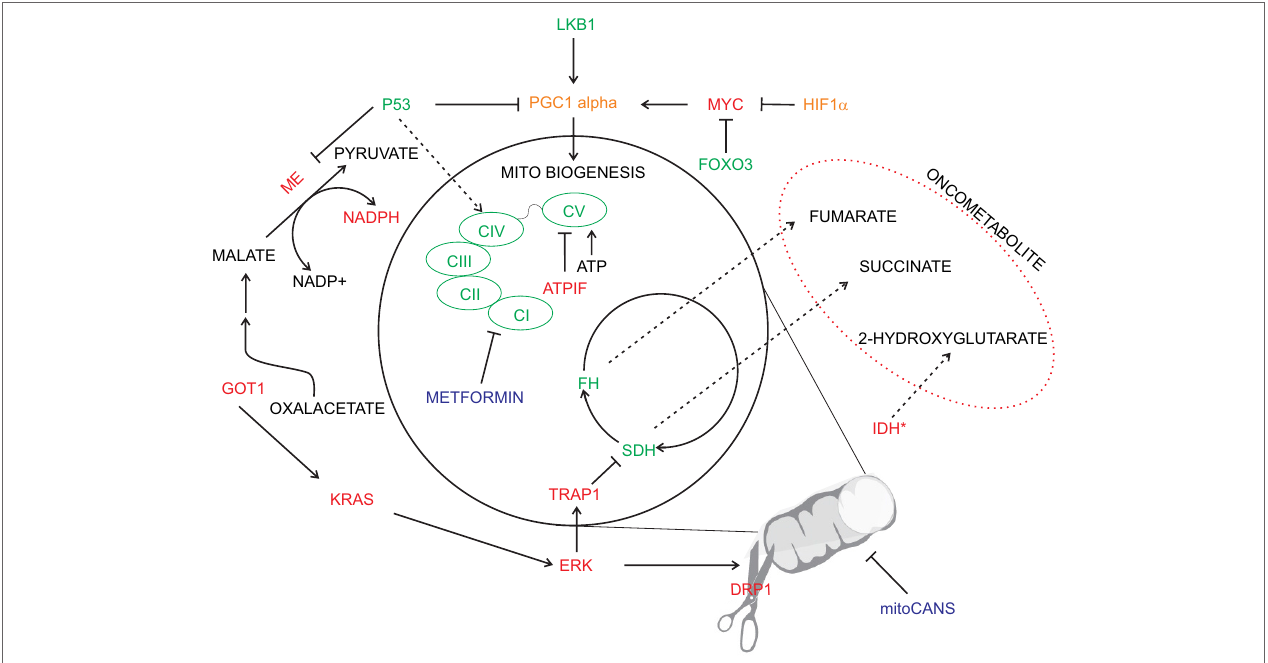
FiGURe 2 | Oncogenic deregulation in mitochondrial metabolism. Physiological mitochondrial metabolism is deranged in cancer by several oncogenic signaling (depicted in red). Inhibition of specific mitochondrial enzymes [i.e., succinate dehydrogenase (SDH) and fumarate hydratase (FH)] or specific mutation [i.e., isocitrate dehydrogenase (IDH)] leads to cellular transformation via the generation of oncometabolites. Similarly, oncogenic drivers affect electron transport chain activity and promote increased oxidative stress buffering (e.g., via malic enzyme-ME). Pro-tumorigenic signals are represented in red and anti-tumorigenic in green. Enzymes with a double pro/anti-tumorigenic signal according to the type of tumor (i.e., PGC1 alpha and HIF1 α ) are represented in orange. The main chemotherapy agents are represented in